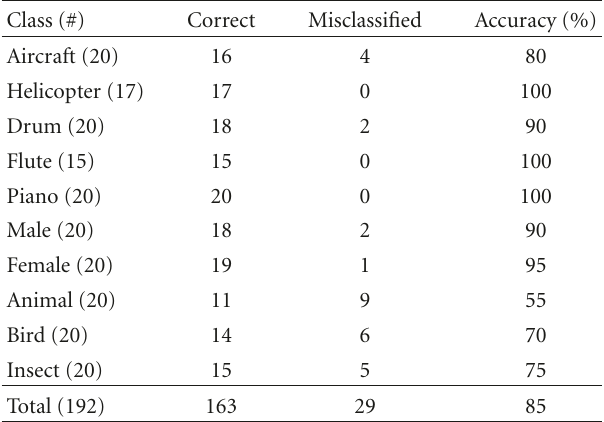
Table 3: Classification results; proposed features extraction